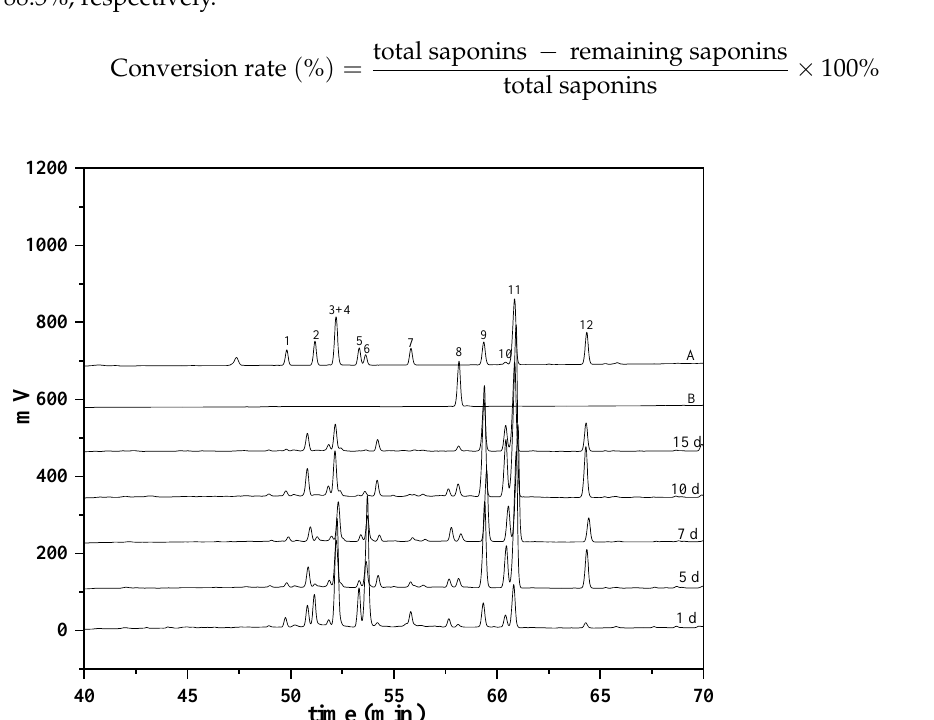
Figure 1. HPLC analysis of major saponins in PNF. (A) Commercial standards; (B) PNF extract; (C) 122 control, culture liquid of strain S7 without added substrate; 1 and 2, unknown saponins. 123 2.3. HPLC Analysis the Dynamic Change of Major Saponins in PNF Transformed by C. 124 xylophilum